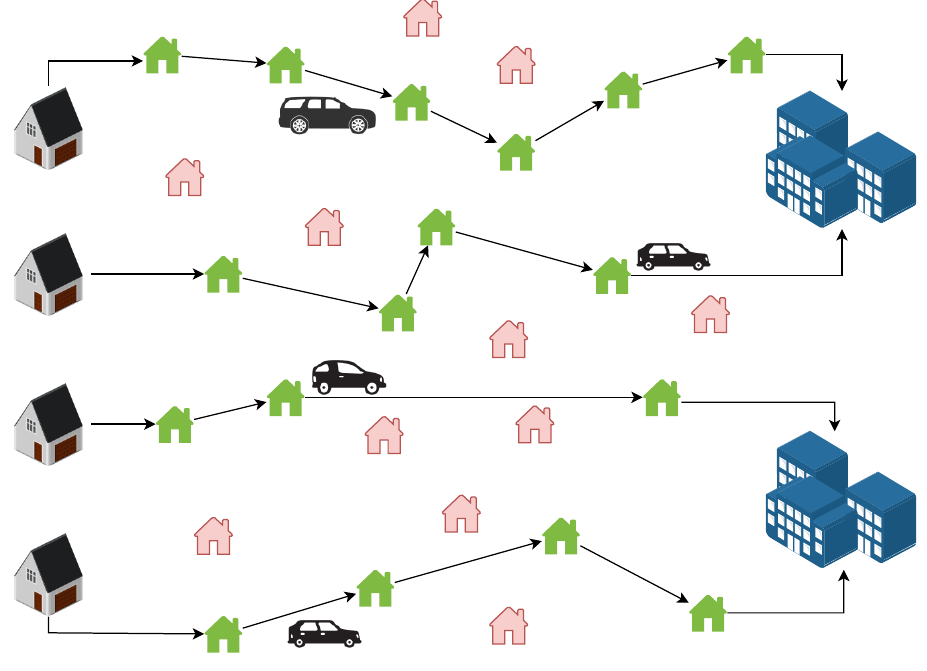
Figure 3. Representation of a complete solution for a static